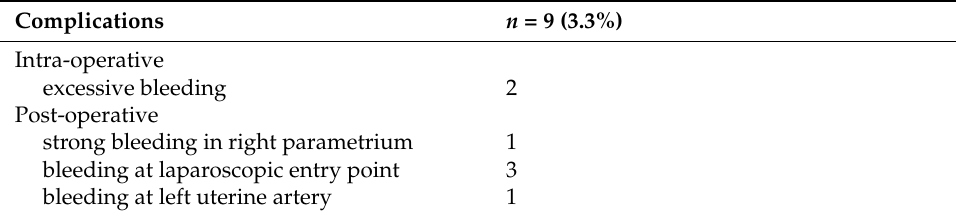
Table 4. Complications of LASH with OS in our Study